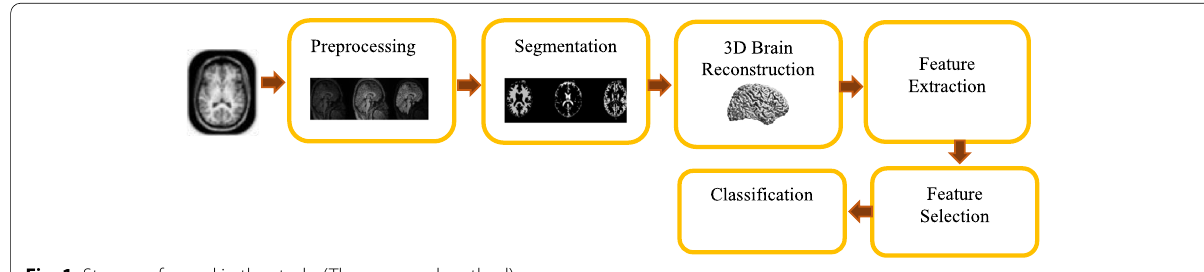
Fig. 1 Steps performed in the study. (The proposed